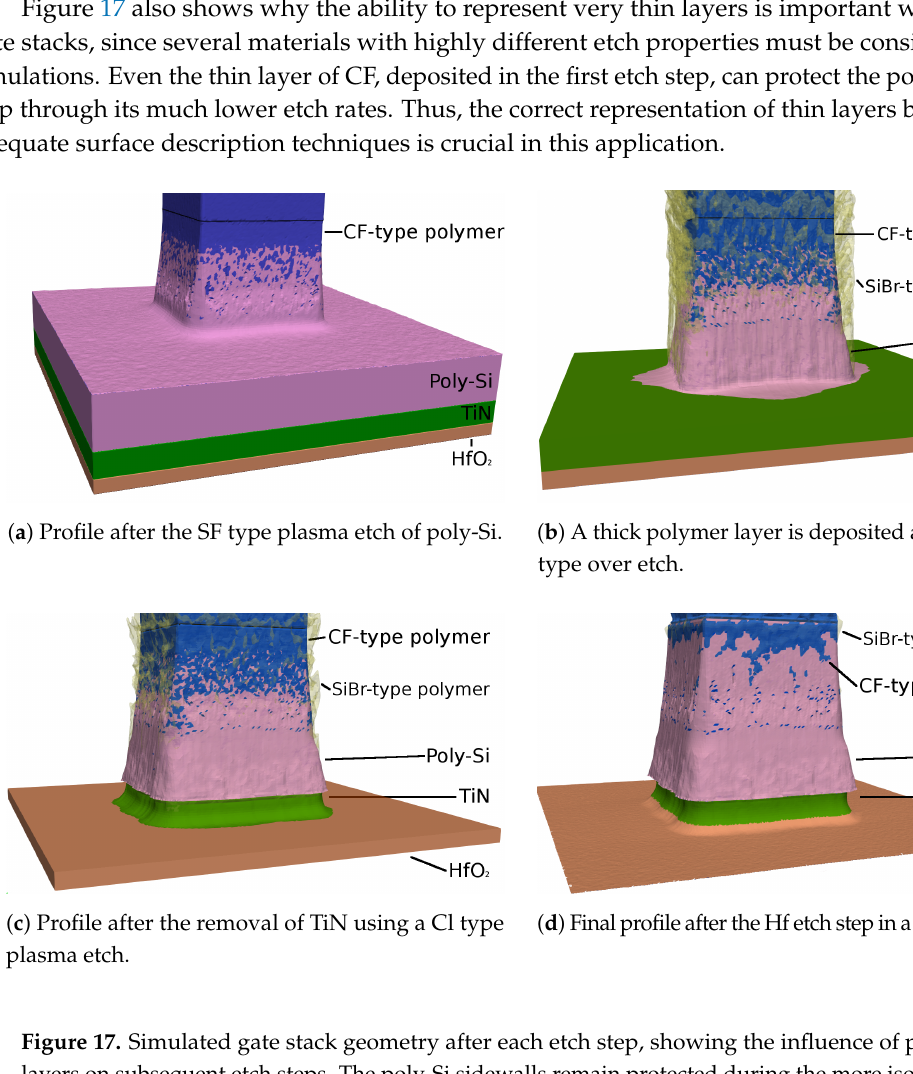
Figure 17. Simulated gate stack geometry after each etch step, showing the influence of passivation layers on subsequent etch steps. The poly-Si sidewalls remain protected during the more isotropic later etch steps, which leads to the under-etch in the TiN and Hf